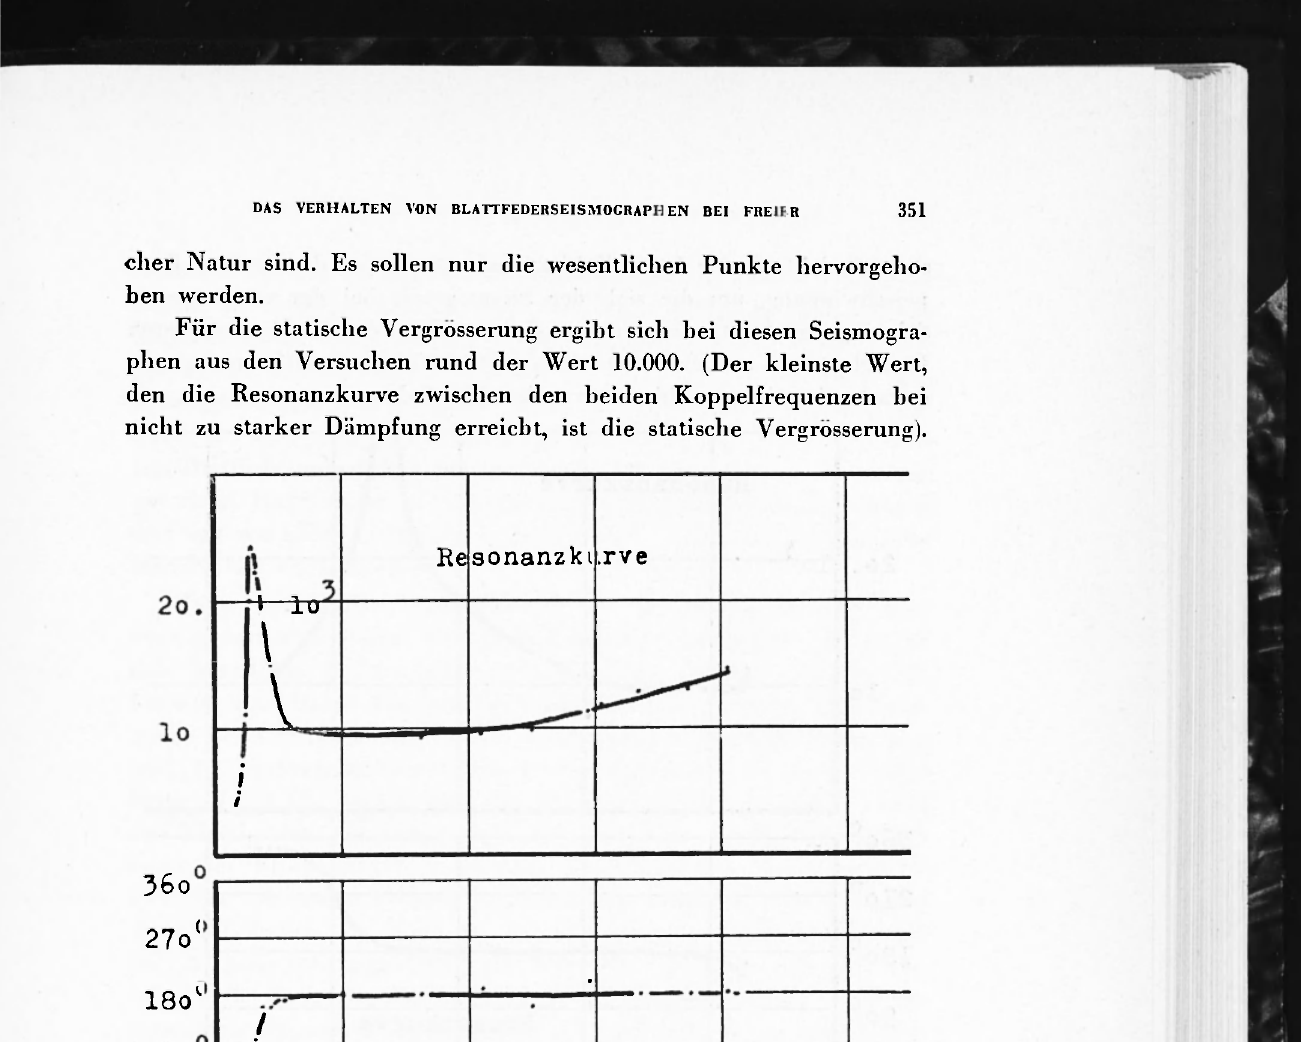
Fig. 7 - Resonanz- und Phasenkurve des Vertikalseismographen Z12. Die Blattfe- dern waren zwischen Stahlbacken geklemmt. Die freie Liinge der Blattfedern betrug 0,02